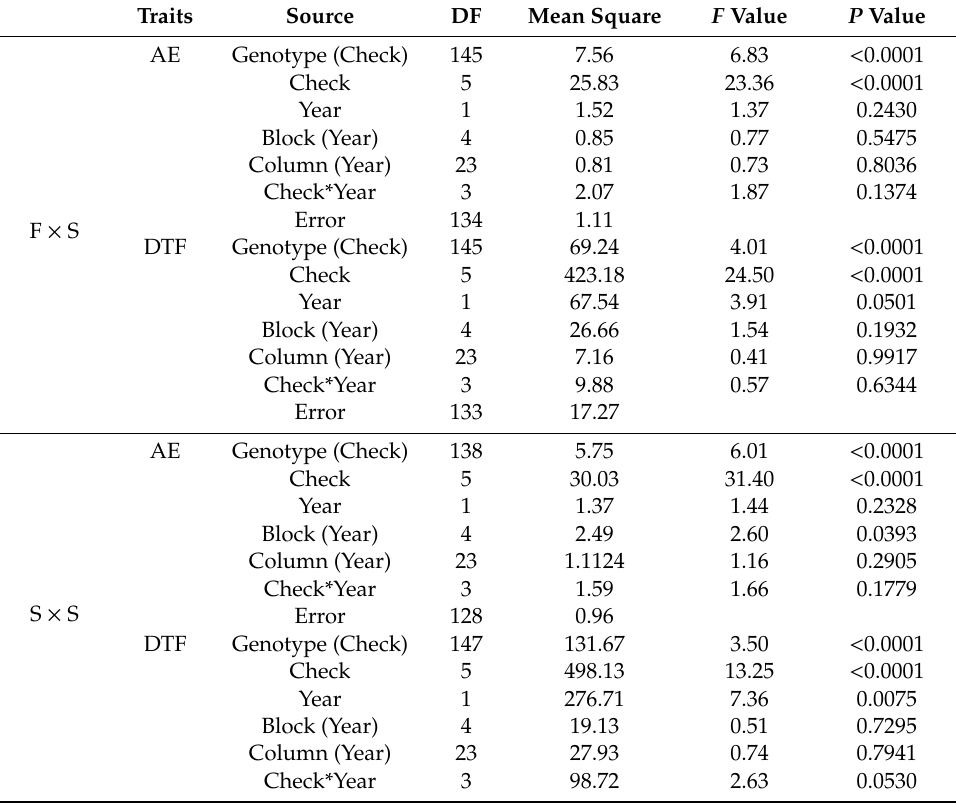
Table 2. Analysis of variance for AE- anther extrusion and DTF (days to flowering) in the Fiia × Stormogul (F × S) and Svea × Stormogul (S × S) recombinant inbred line populations tested during 2012 and 2013.